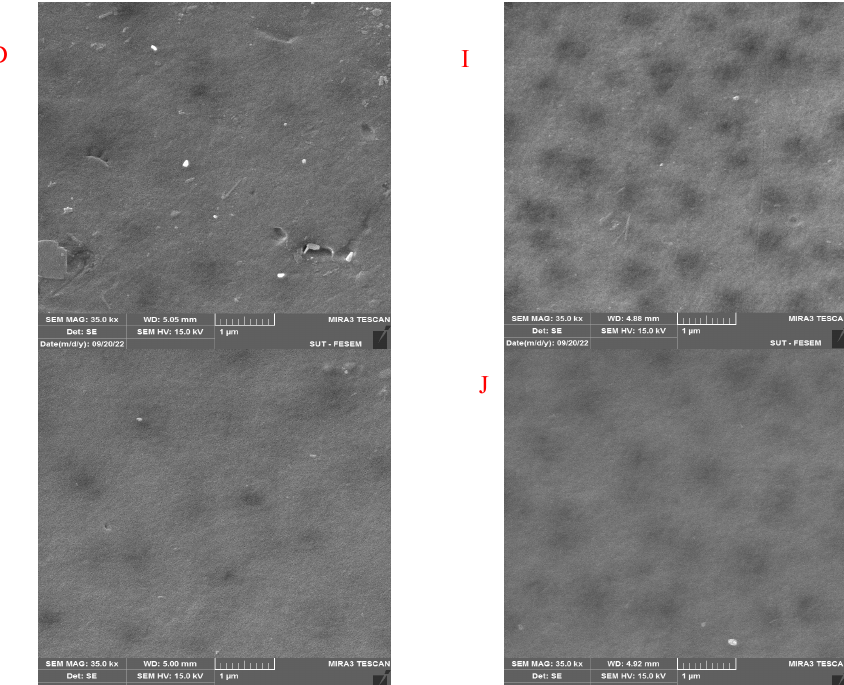
Figure 7. FESEM surface images for ( A ) pure PPSU membrane, ( B ) with 0.05% GO-WO 2.89 /PPSU ( C ) with 0.1% GO-WO 2.89 /PPSU, ( D ) with 0.15% GO-WO 2.89 /PPSU, ( E ) with 0.2% GO-WO 2.89 /PPSU, ( F ) pure PPSU/PVP membrane, ( G ) with 0.05% GO-WO 2.89 /PPSU/PVP ( H ) with 0.1% GO- WO 2.89 /PPSU/PVP, ( I ) with 0.15% GO-WO 2.89 /PPSU/PVP, ( J ) with 0.2% GO-WO 2.89 /PPSU/PVP.